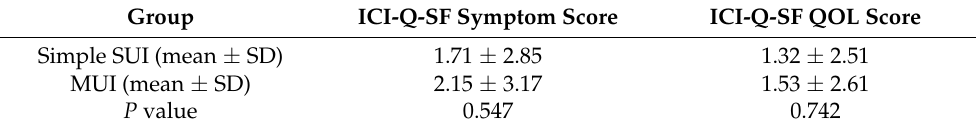
Table 5. Comparison of postoperative quality of life scores between simple SUI and MUI patients. (x ± s). Group